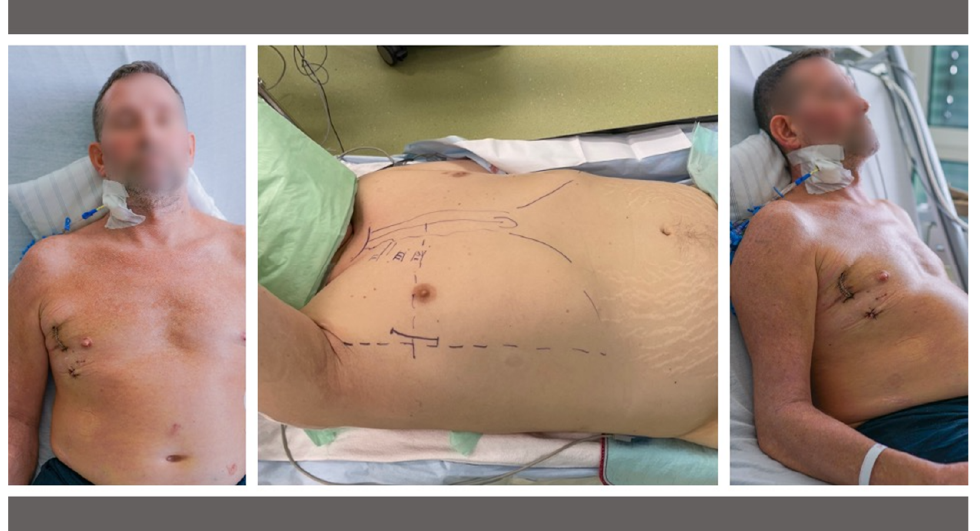
Figure 1. Intra-operative setup ( middle ) and the postoperative cosmetic result ( left / right ) of transaxillary minimally invasive mitral valve surgery on postoperative day 2.